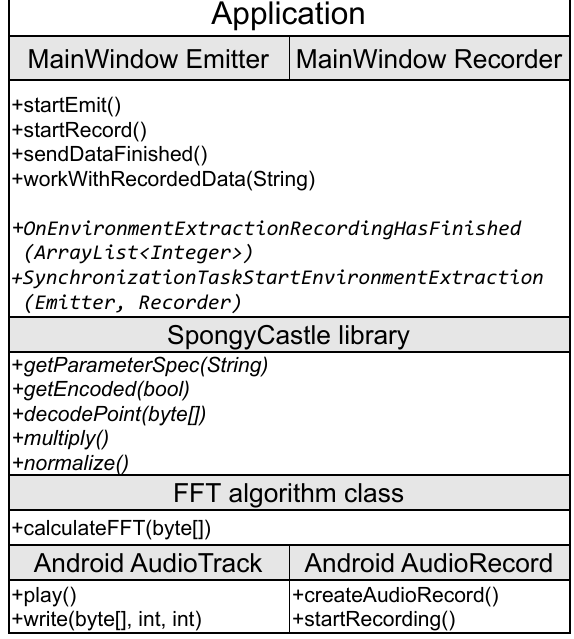
Figure 4. Implementation stack.